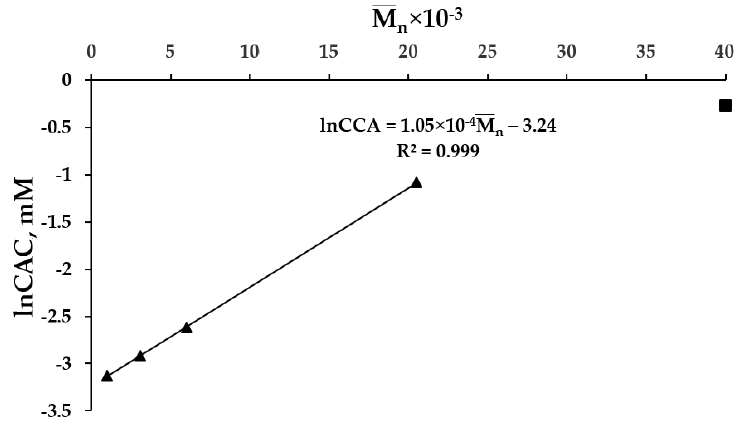
Figure 3. Concentration dependence of the critical aggregation concentration on the number average molecular mass plotted ln(CAC) vs. 𝑀̅ 𝑛 .